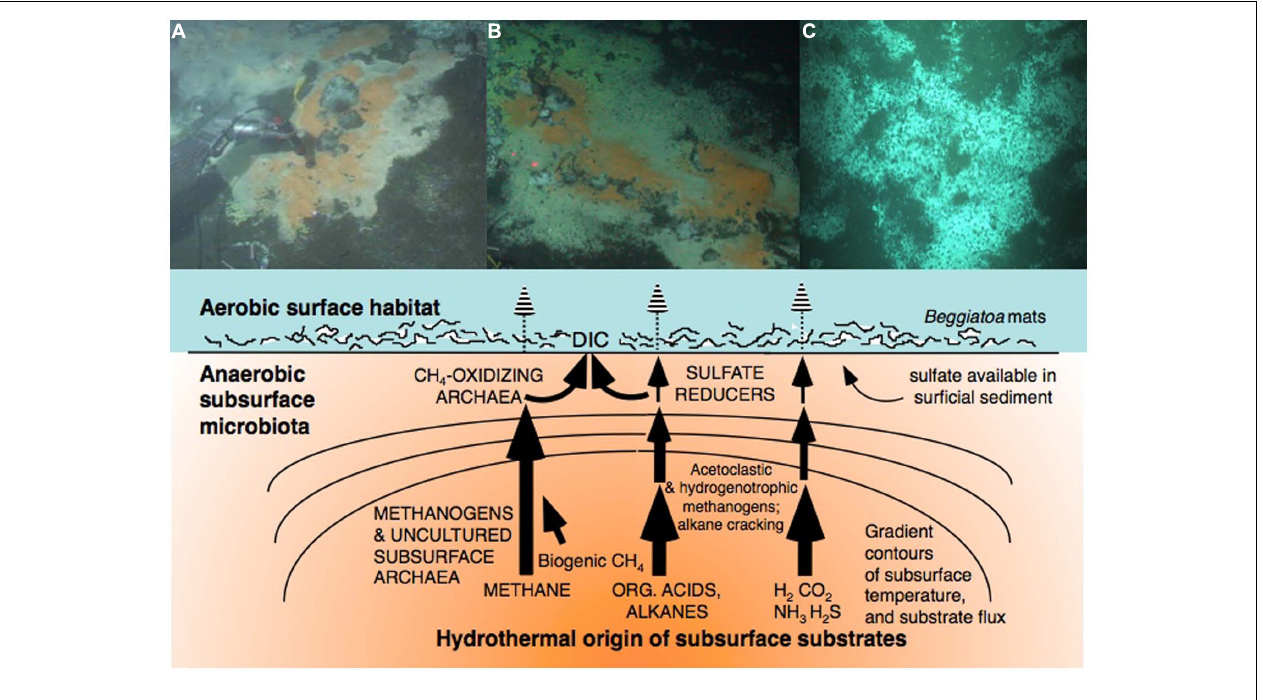
FIGURE 2 |The microbial gauntlet modifies the fluxes of deep carbon and gasses toward the sediment surface. The top row shows examples for sulfur-oxidizing microbial mats dominated by filamentous Beggiatoaceae at well-documented hydrothermal seepage hot spots